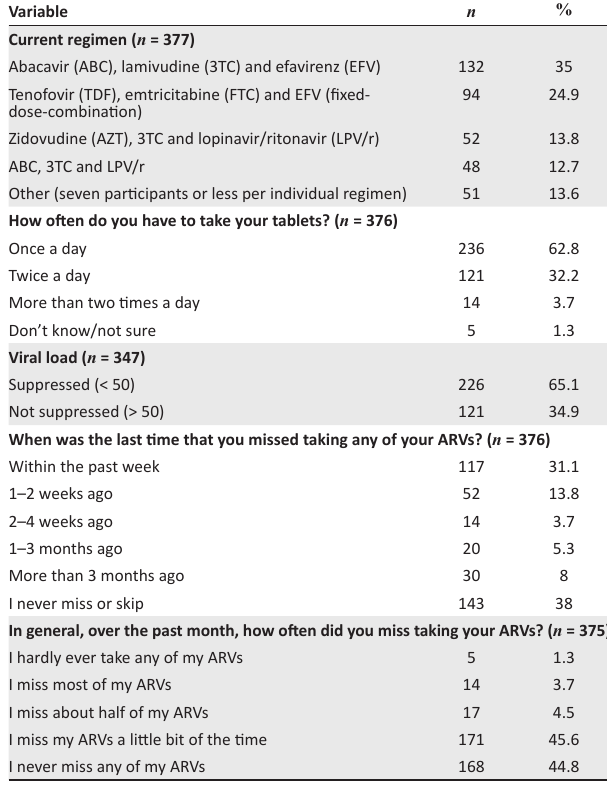
TABLE 3: Regimen, adherence and viral load.